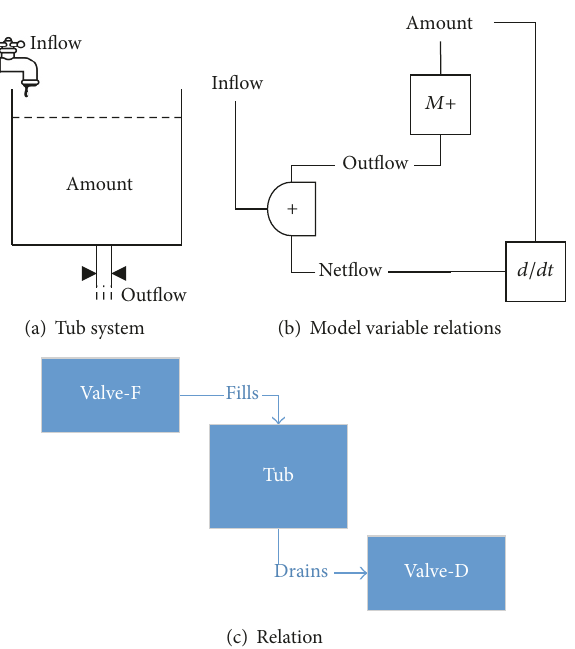
Figure 2: Bathtub problem graphical